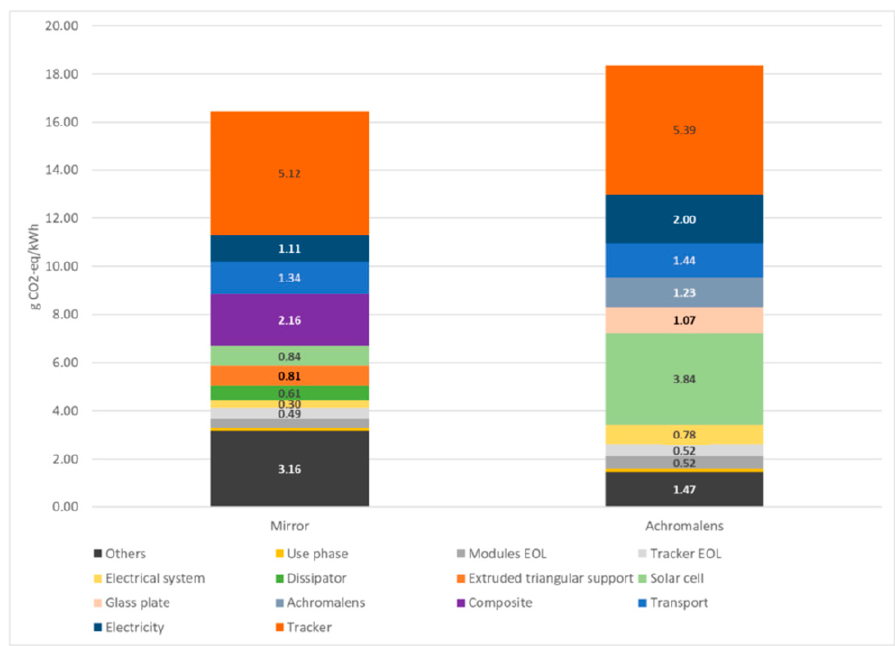
Figure 2. The results of impacts on climate change are expressed in g CO 2 -eq impact per process distribution. The sum of all processes for mirror and Achromalens systems corresponds to 16.4 and 18.4 g CO 2 -eq / kWh, respectively. All processes contributing to more than 5% are detailed. Smaller processes are gathered in “Others”.